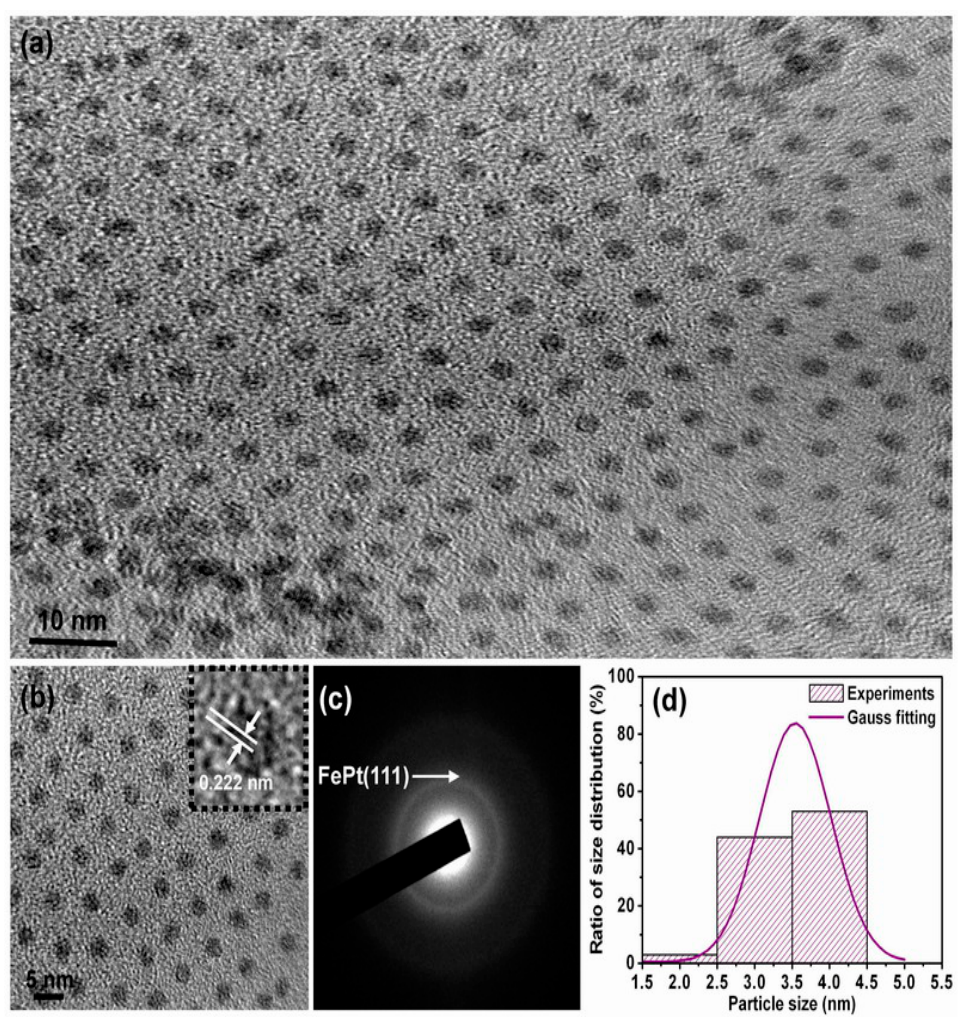
Figure 1. Transmission electron microscopy (TEM) bright field images for the FePt NPs synthesized in phenyl ether capped with oleic acid and oleylamine ligands, respectively. ( a ) Low-magnification image; ( b ) Enlarged magnification of ( a ) and the inset TEM image is high-resolution transmission electron microscopy (HRTEM) of an individual sphere NP; ( c , d ) selected area of diffraction (SAD) and particle size distribution with Gauss fitting curve, respectively.